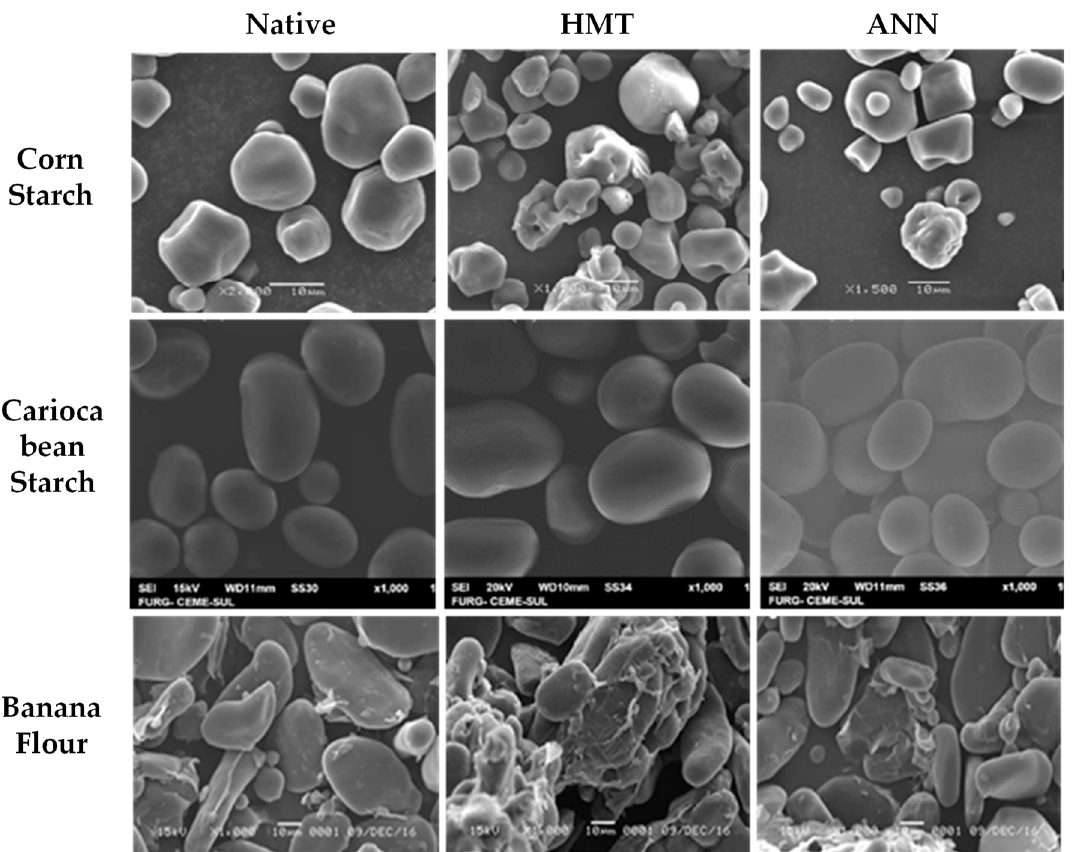
Figure 2. Starch granule morphology of HMT and ANN treatment was analyzed by scanning electron microscope (SEM) of maize starch [86], with permission from John Wiley and Sons, 2016, carioca bean starch [82], with permission from Wiley and Sons, 2018, and banana flour [63], with permission from Elsevier, 2019.